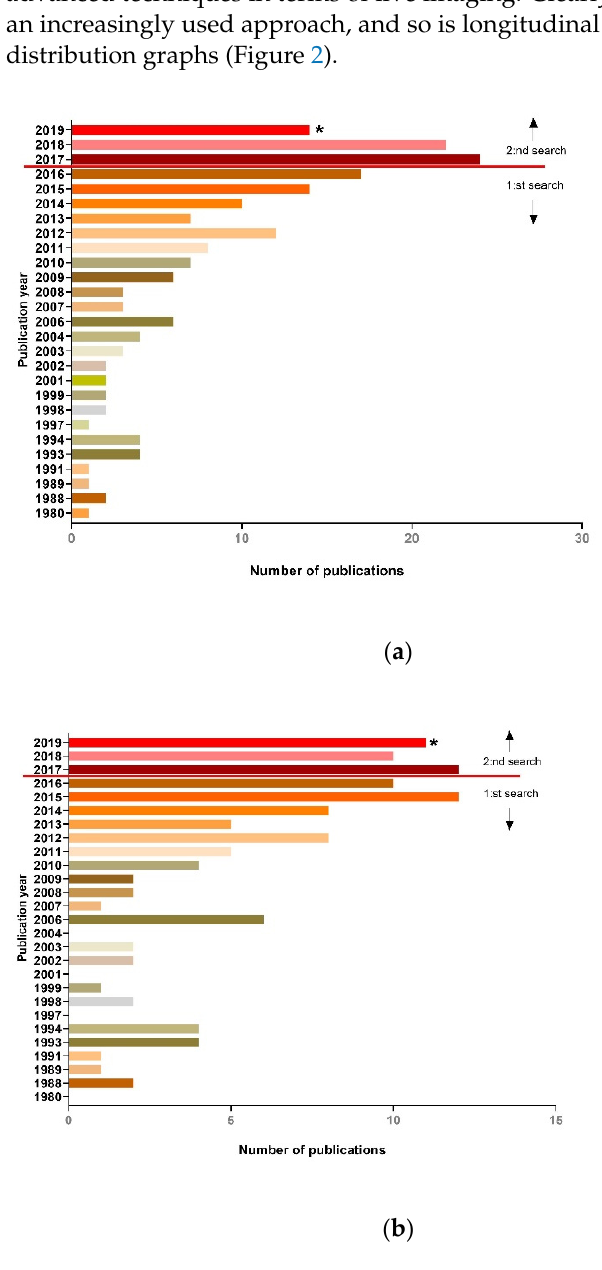
Figure 2. Time plots of the included articles that data was extracted from. Red line indicated articles that were included from the first and second search, respectively. ( a ) The total amount of articles published. ( b ) All articles that used longitudinal imaging as readout in their lung injury model. * = points out year 2019, which only includes articles published in the first half year of 2019 (January–July).